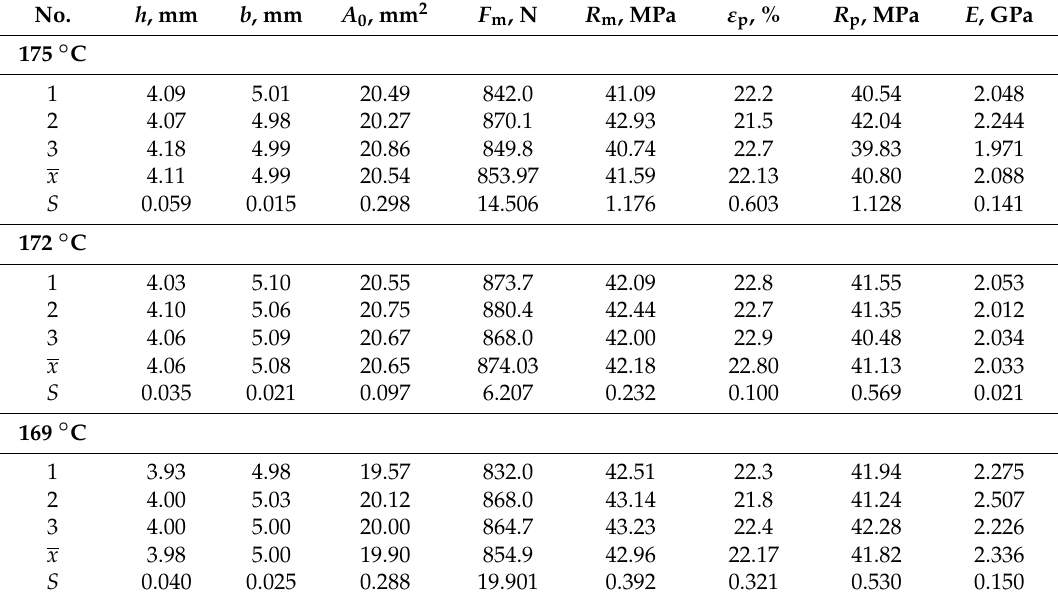
Figure 8. Influence of chamber temperature on the tensile properties. Table 1. Tensile properties with different chamber temperature.